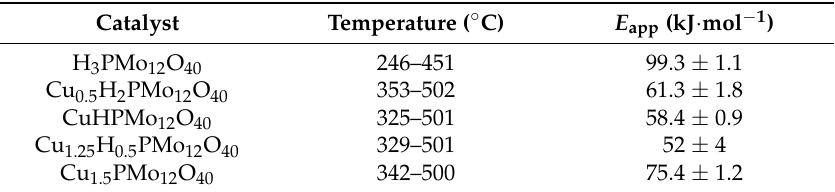
Table 1. Apparent activation energies calculated for the selective oxidation of isobutane to methacrolein over phosphomolybdic acid and copper(II) phosphomolybdates, reproduced with permission from [10]. Copyright Elsevier,